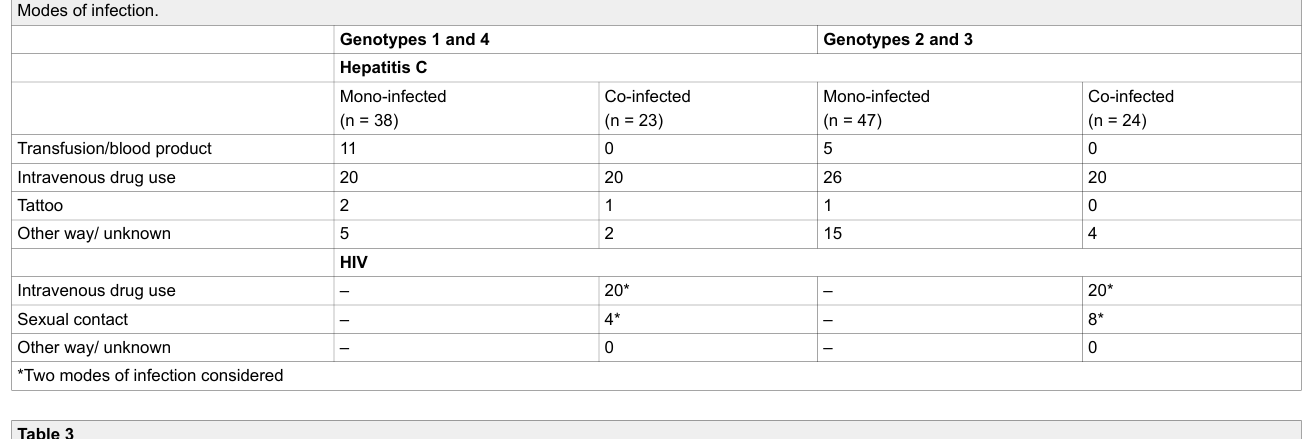
Table 2 Modes of infection.